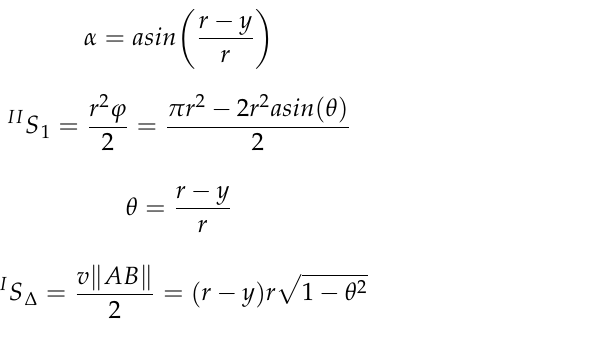
Figure A2. Cross-section of AmbuBag.